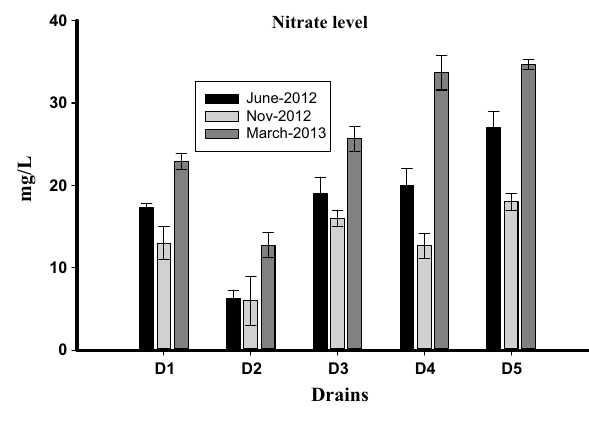
Fig. 3 Nitrate level of different drains of HIE